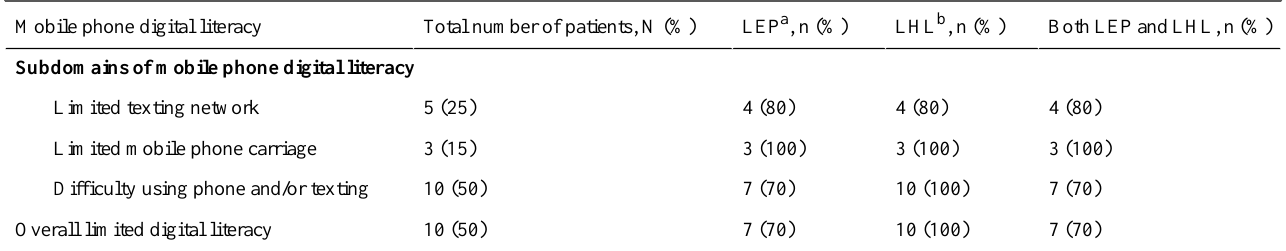
Both LEP and LHL, n (%)LHL b , n (%)LEP a , n (%)Total number of patients, N (%)Mobile phone digital literacy